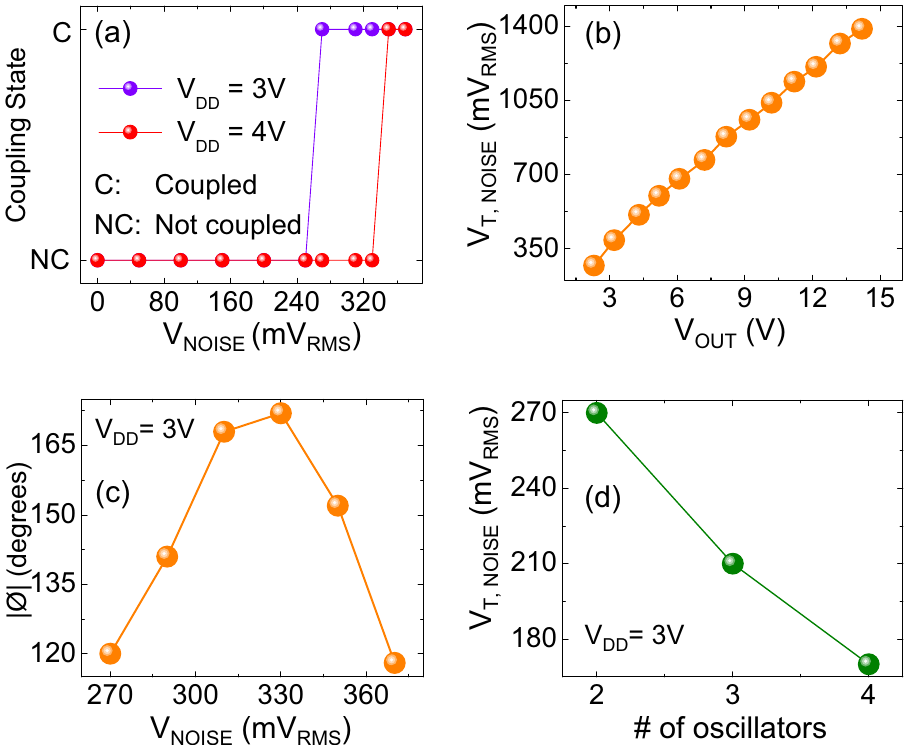
Figure 2. ( a ) Effect of noise voltage on the synchronization of the two oscillators for two different biases (V DD = 3 V, 4 V). ( b ) Variation of noise threshold (for frequency locking) with amplitude of the output. ( c ) Evolution of the relative phase difference (Ø) between the synchronized oscillators as function of the noise voltage. ( d ) Minimum noise threshold (V T,NOISE ) required for synchronization as a function of the number of oscillators; the threshold decreases with increasing number of